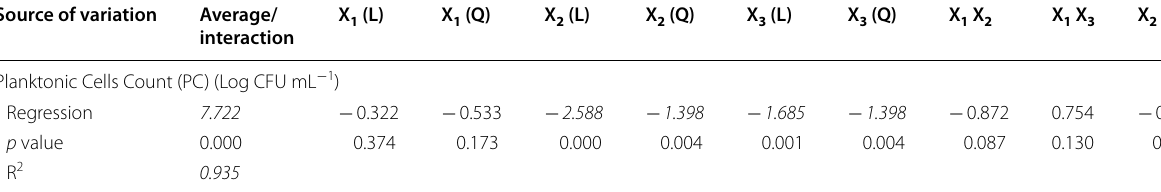
Significant values ( p < 0.05) are highlighted in italics